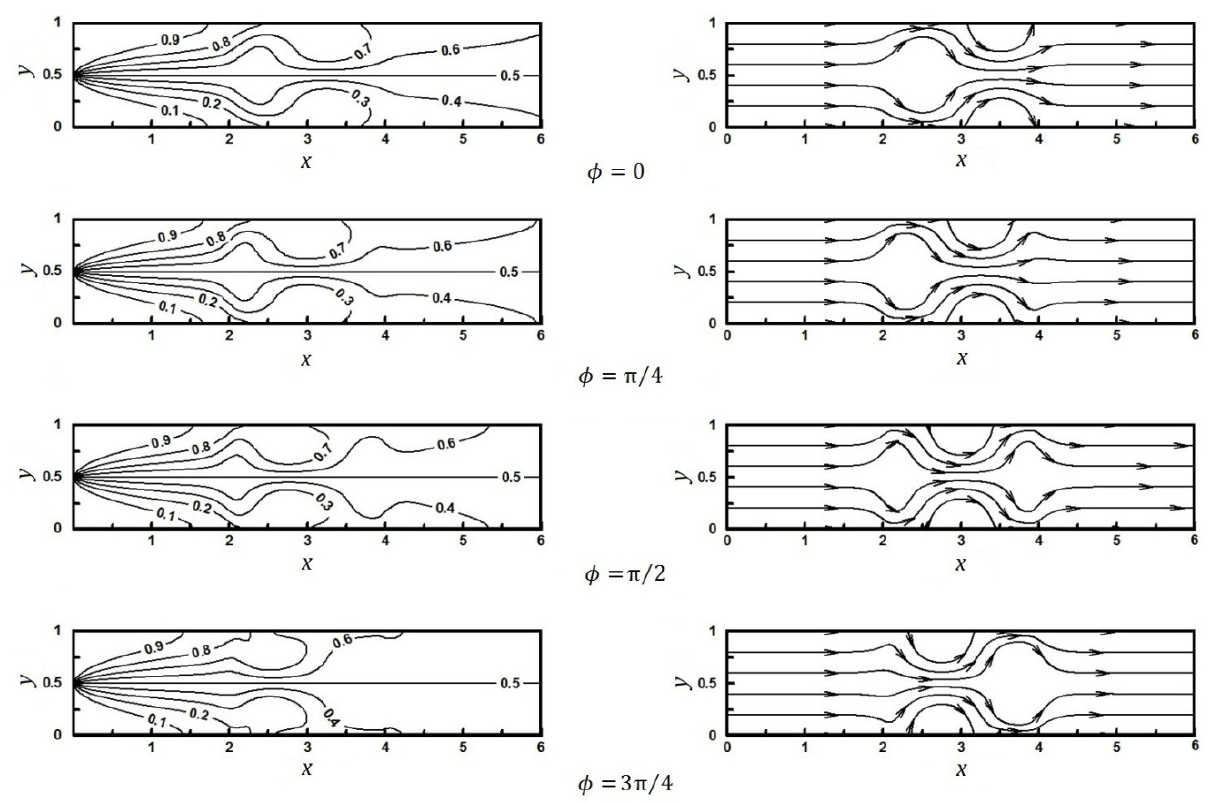
Figure 4. Flow fields related to Equation (20): Streamlines (right side) and concentration lines (left side).